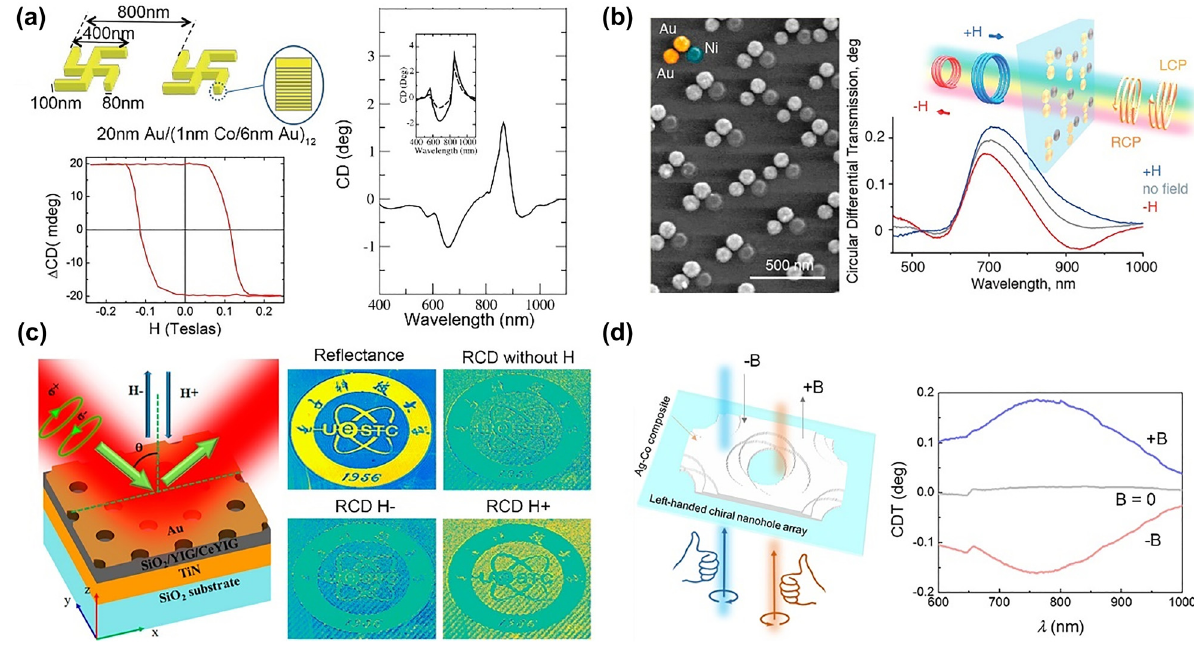
Figure 4: Chiral magnetoplasmonic devices. (a) Chiral magnetoplasmonic metasurface based on Au/Co multilayers shaped with gammadioncrosses. A large CD (1.5 deg) presented in the gammadion crosses with magnetic tunable CD up to ± 20 mdeg. (b) Chiral magnetoplasmonic metasurface based on Au – Au – Ni trimers. The circular differential transmission shows large variation under positive, negative, and zero applied magnetic fi elds. (c) Chiral magnetoplasmonicmetasurfacebasedonAu periodicnanohole/Ce:YIG/YIG/SiO 2 /TiNmultilayers.Chiralimagingmodulated bythemagnetic fi eld. (d) Chiral magnetoplasmonic metasurface based Ag/Co chiral nanohole arrays with in-plane symmetry breaking. A large magnetic fi eld tunablecirculardifferentialtransmissionisdemonstratedinthismagnetoplasmonicchiralstructure.Thepanelsofthis fi gurecontainpictures adapted from References [99, 101 –